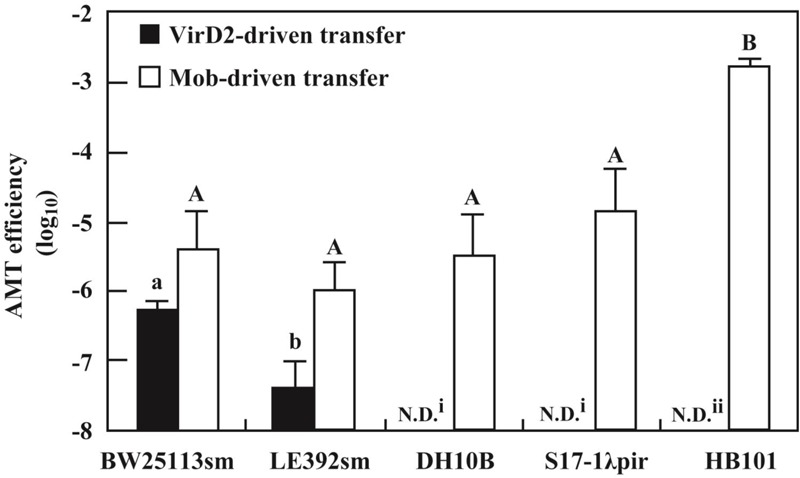
Variation of AMT efficiency among E. coli laboratory strains. AMT was applied to five E. coli laboratory strains as shown in Figure 2. The donor strains used were EHA105 (pSRK-R316) (filled bar) and EHA105 (pAY205) (open bar). N.D. means no transformed offspring were detected (i < 1 × 10-8, ii < 4 × 10-6). Different letters indicate significant difference (P < 0.05) by the Tukey–Kramer test.